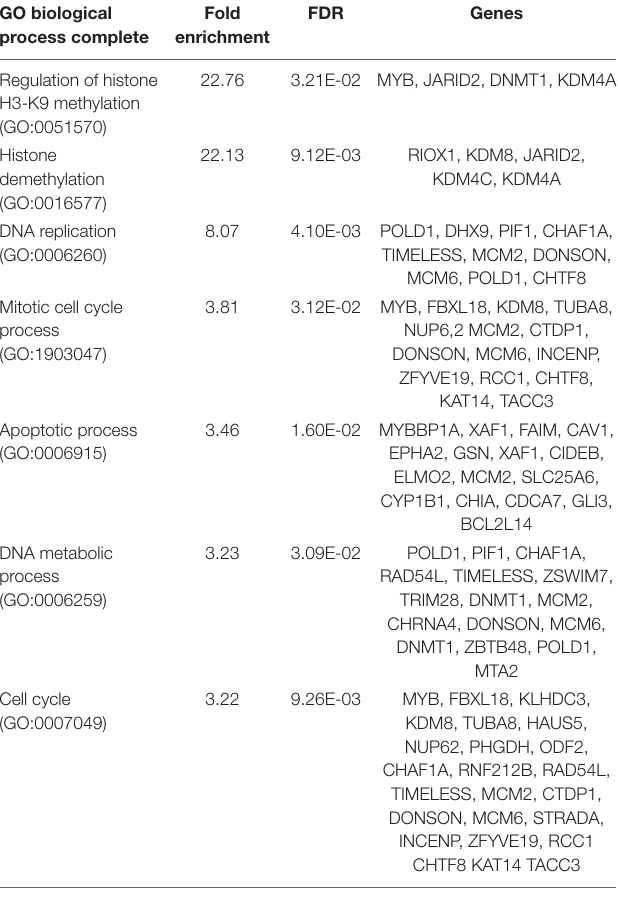
Fold FDR enrichment